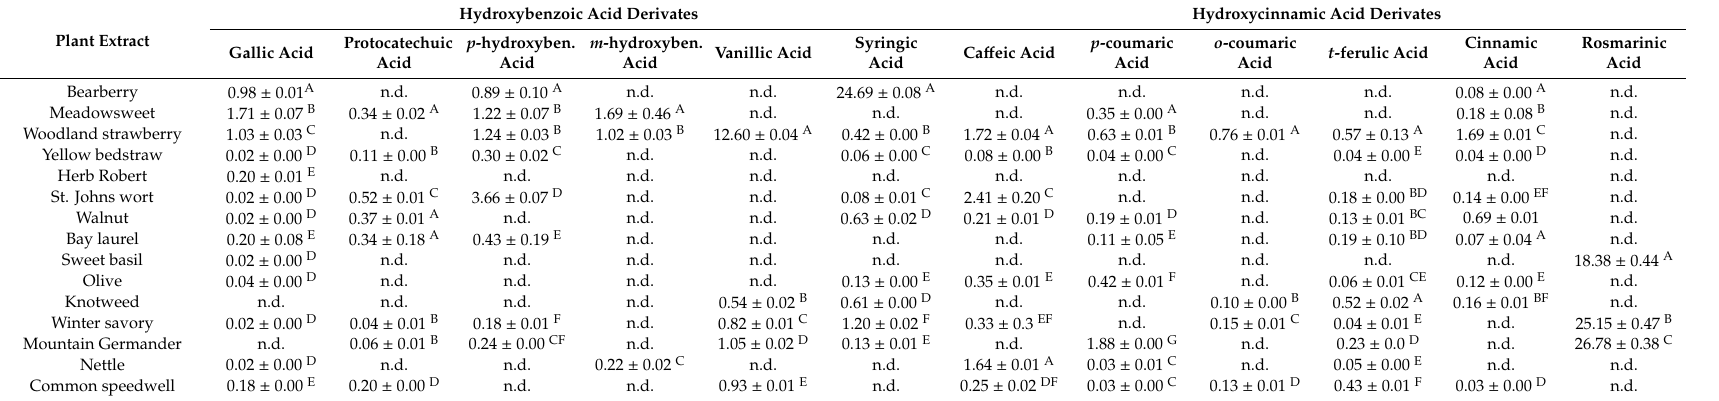
Table 3. Profile of the phenolic acids (mg / g) in investigated herb extracts.